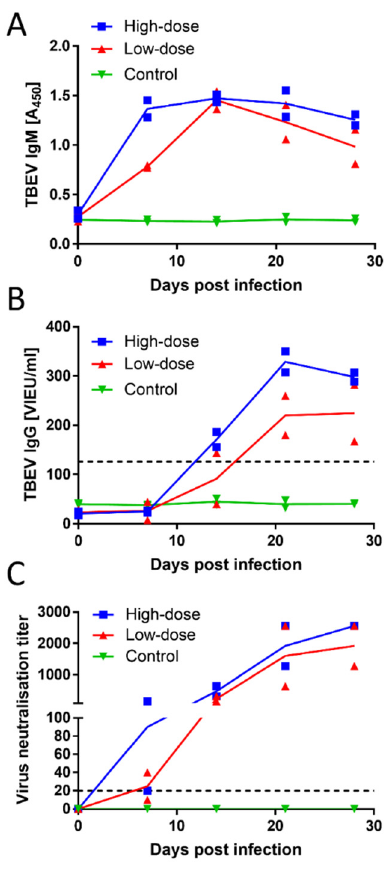
Figure 2. Antibody responses in dogs experimentally infected with TBEV. Six beagle dogs were included. TBEV was inoculated at 10 8 PFU/per dog (high-dose group, n = 2, blue squares ), TBEV at 10 6 PFU/per dog (low-dose group, n = 2, red triangles ), or no TBEV (control group, n = 2, green inverted triangles ). Blood samples were collected on days 0, 7, 14, 21, and 28 p.i. ELISA results show ( A ) TBEV-specific IgM, and ( B ) IgG levels in blood sera from individual dogs; ( C ) Individual levels of TBEV-neutralising antibodies, assayed with VNTs. The dashed lines in ( B , C ) indicate thresholds for positive antibody detection.